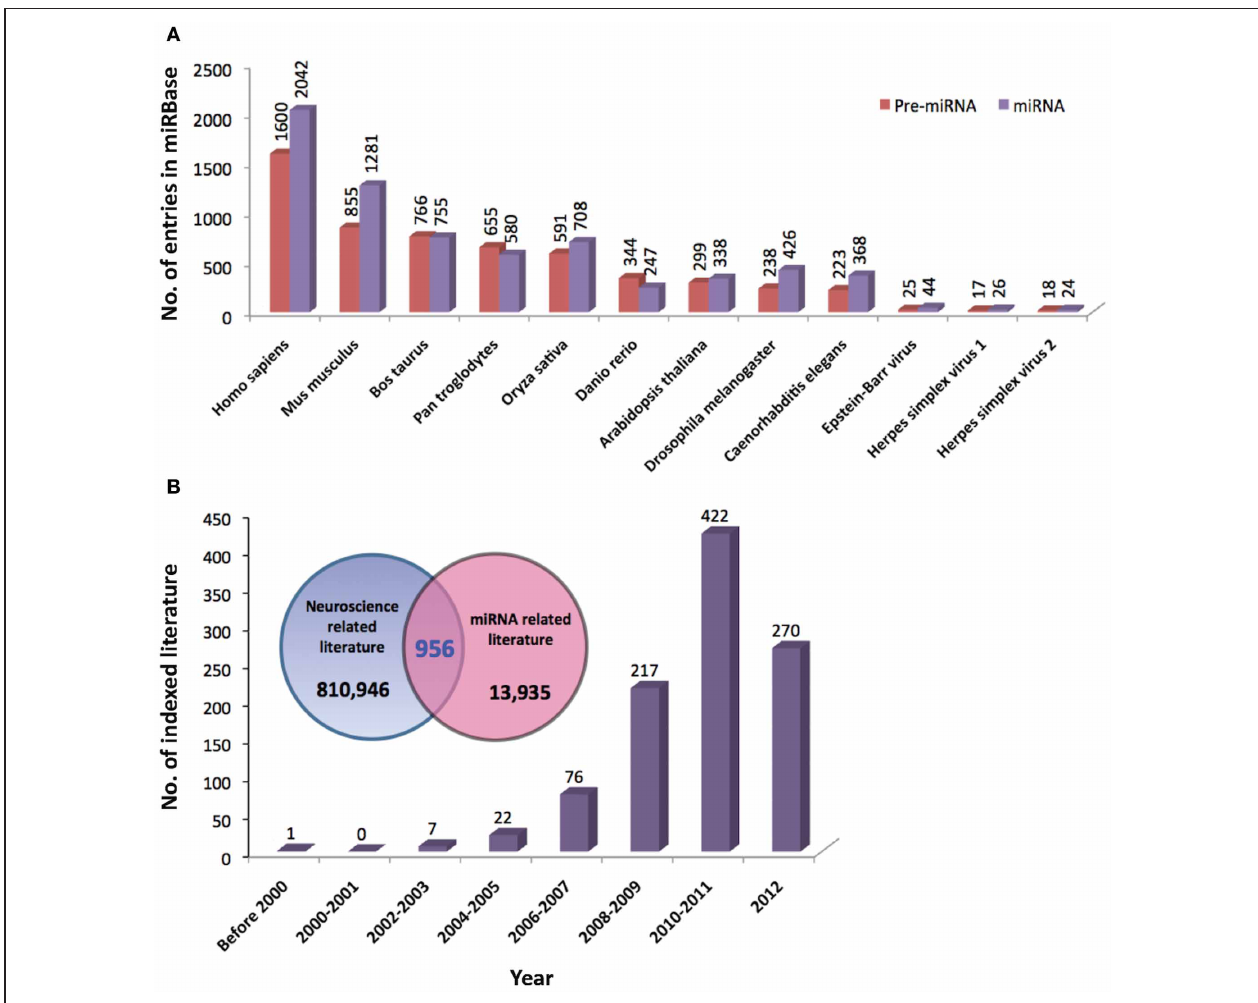
FIGURE 1 | (A) Total number of precursor and mature miRNAs from various species of organisms indexed by miRBase (www.miRBase.org; miRBase v19 accessed on 8/11/2012). (B) The Venn diagram shows the total number of neuroscience- and miRNA-related literature indexed in PubMed. Neuroscience-related literature were searched based on the following terms/functions used in the title/abstract of the literature; (1) neuroscience or (2) brain or (3) neuron or (4) neuron or (5) glia or